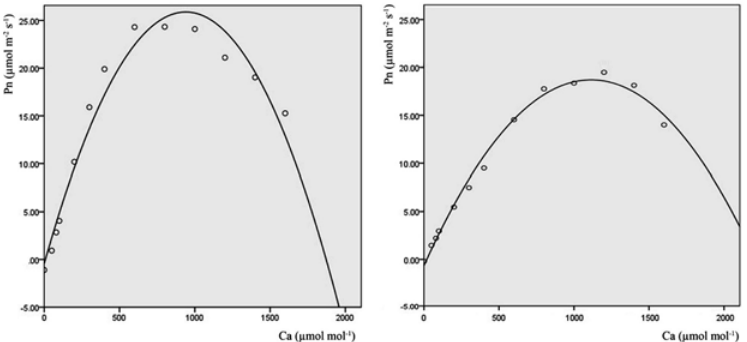
Fig 8. Pn-Ca simulated curve of clone sn3.8 (left) and sn2.3 (right). Solid lines are the simulated curves and white circles are the observed data.